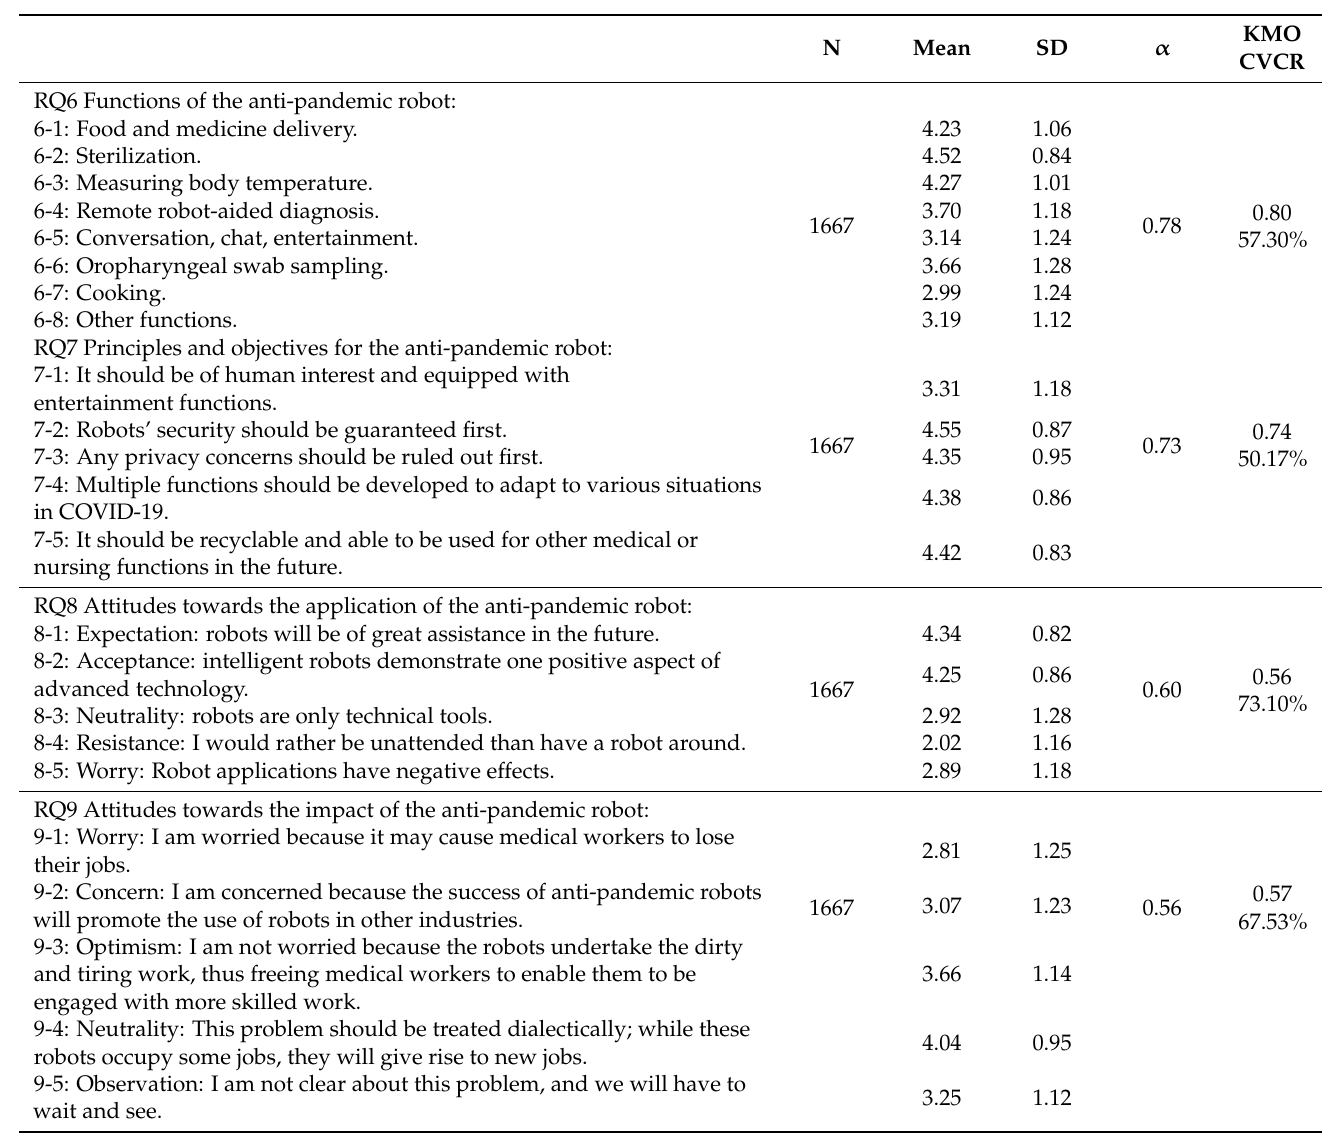
Table 2. Descriptive Statistics of Variables of RQ6–RQ9. N α